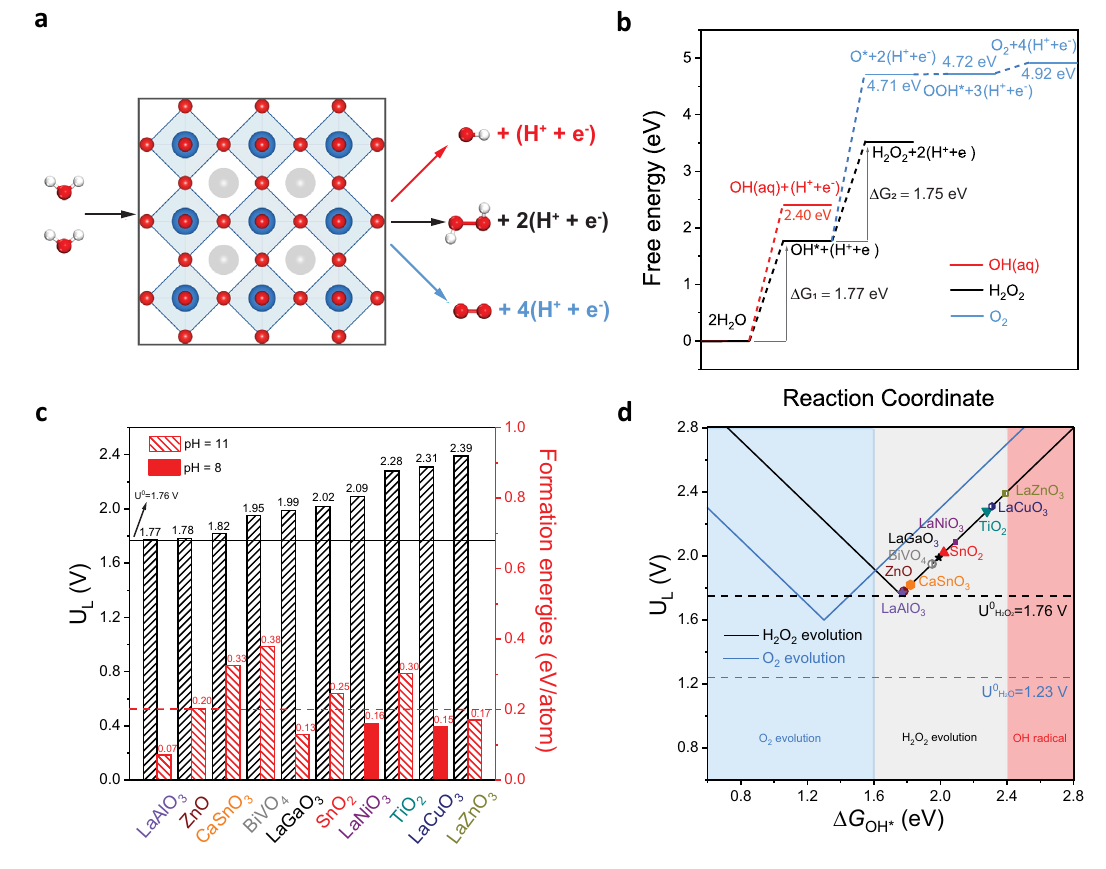
Fig. 2 | Mechanism of the 2e-WOR H 2 O 2 production in LaAlO 3 and comparison of limiting potential and formation energy with different catalysts. a WOR processesviadifferentpathways.La,Al,O,andHarerepresentedbygray,blue,red, and white spheres, respectively. b Free energy diagram of all the three WORs over